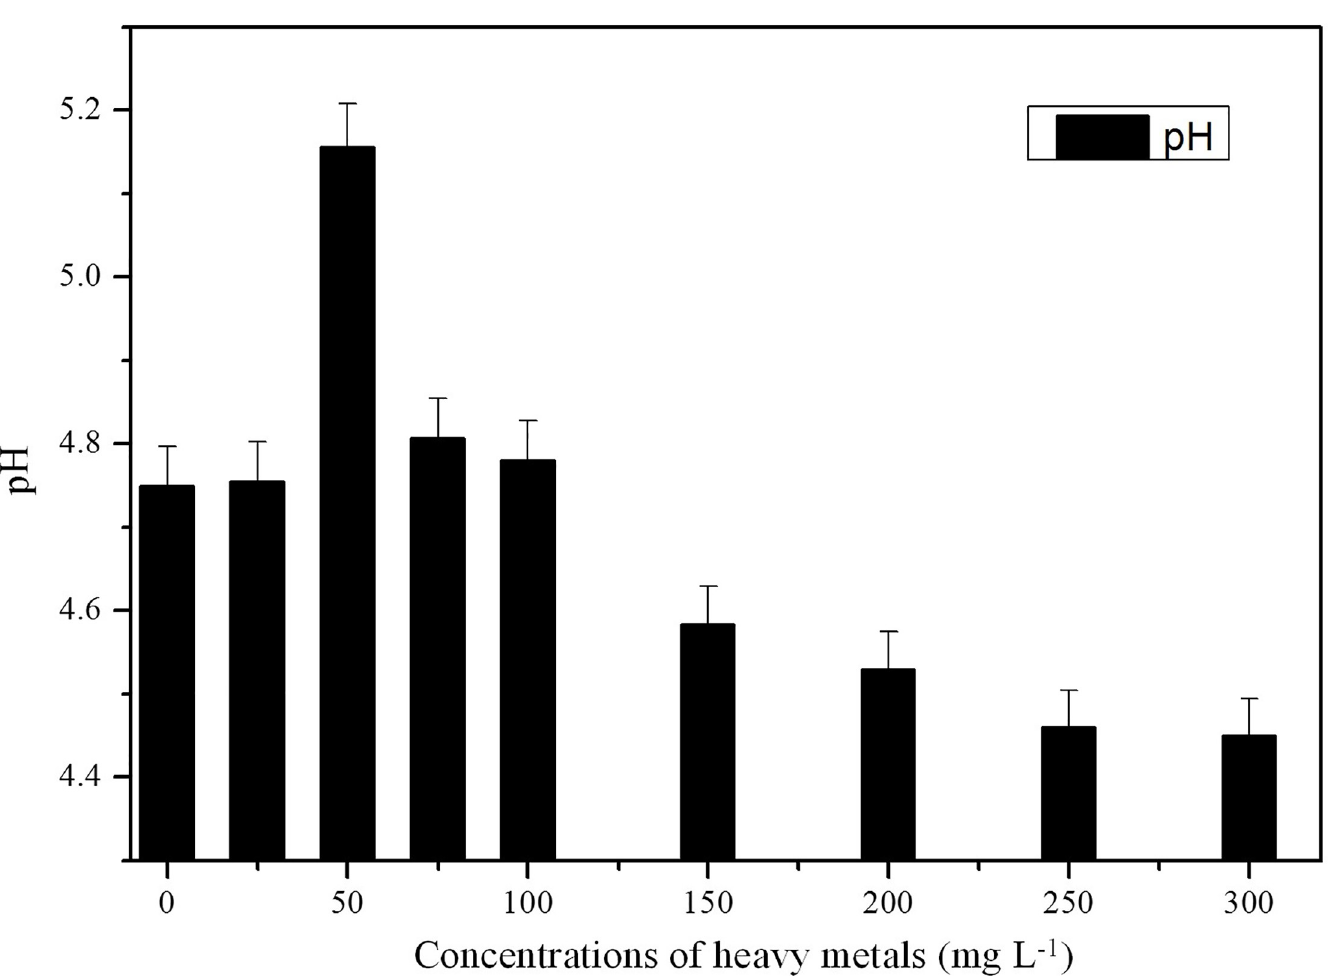
Fig 8. Changes in pH after biosorption at different concentrations. Biosorption conditions: initial pH = 4, absorption time 7 days, initial biomass does 2mL L -1 , temperature 30˚C.